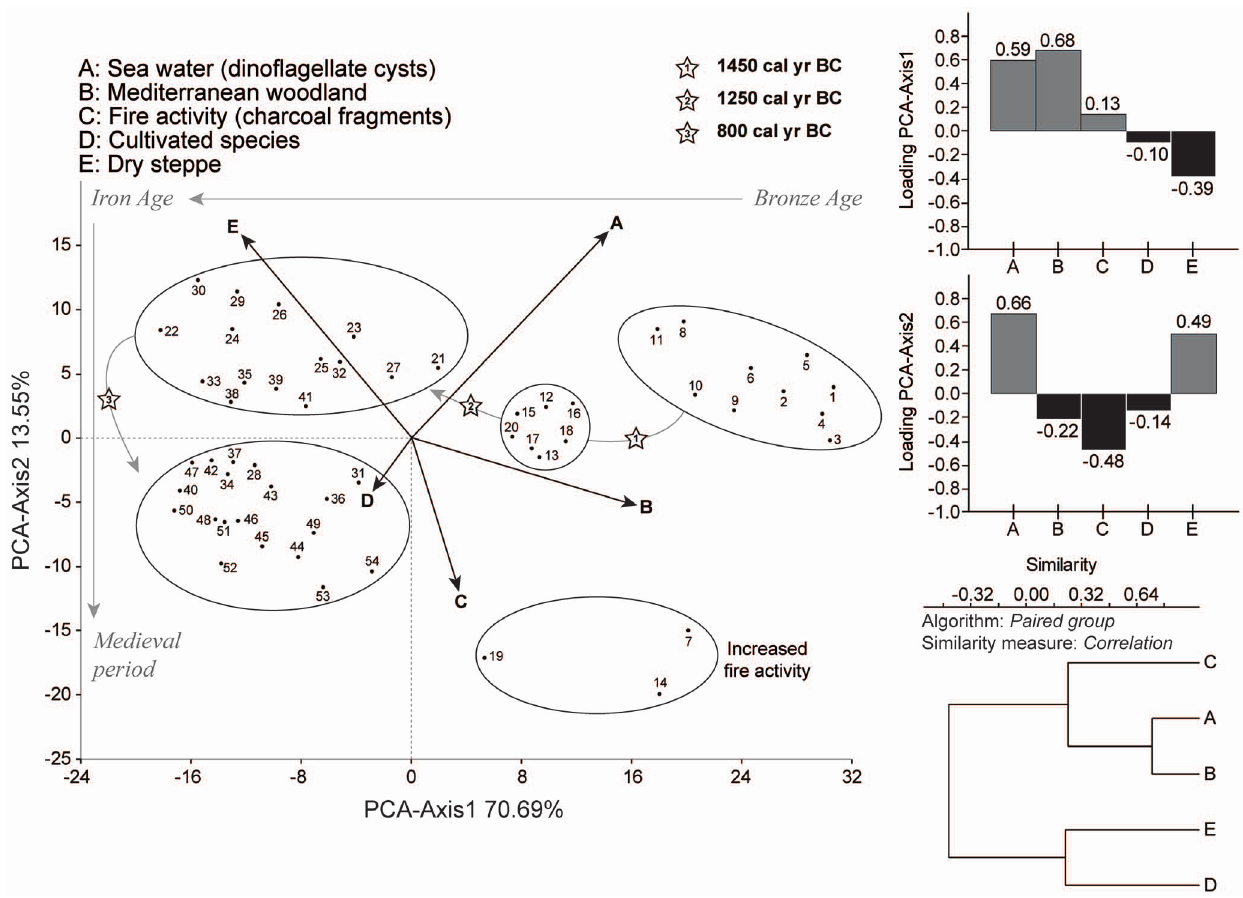
Figure 4. Biplot PCA showing the distribution of samples according to the two main PdVs and environmental factors. PCA axes 1 and 2 account for 84.2% of the cumulative variance. The cluster analysis of the two main PdVs and environmental factors from the core B 22 was computed with paired group as algorithm, and correlation as similarity measure.